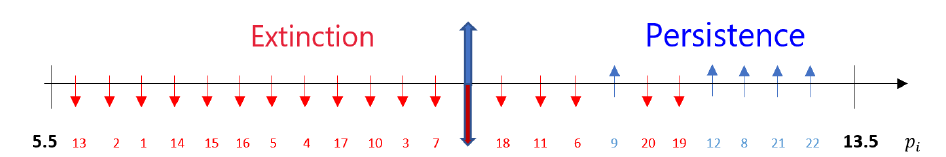
< k > calculated according to (18): red arrows mark the values of p Figure 9. Values of p = 2 β − corresponding to domains with subpopulation extinction (see Table 1), blue arrow mark the values of p i corresponding to persistence clusters (see Table 2); the position of the arrows is approximate. Numbers correspond to case numbering in the tables. The corresponding critical value (shown by the double red-blue arrow) is estimated as p ∗ ≈